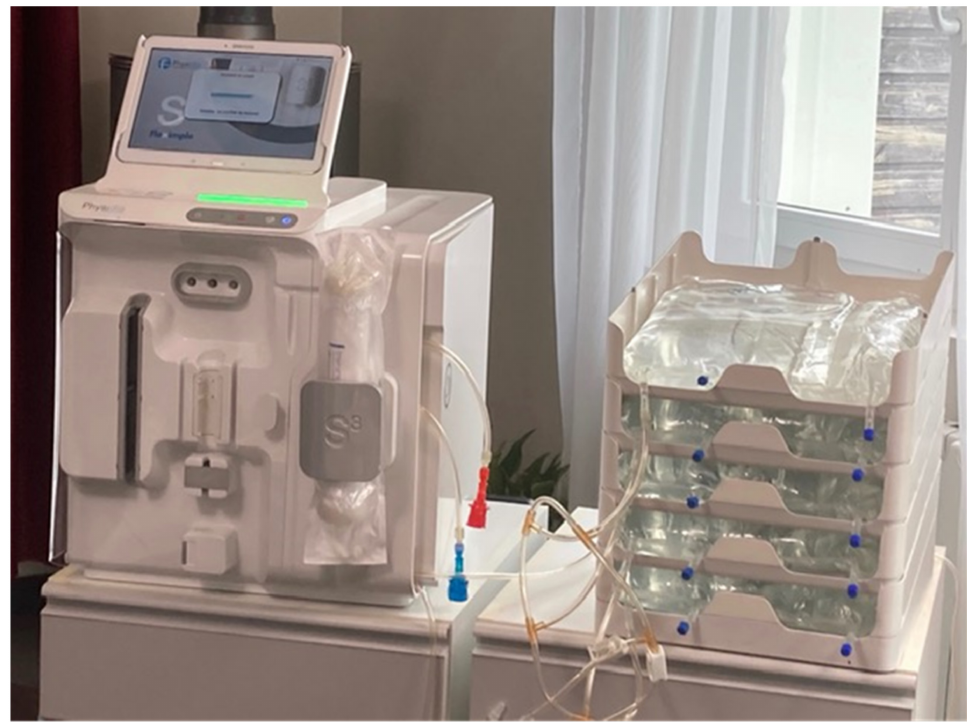
Figure 1. A Physidia S 3 hemodialysis